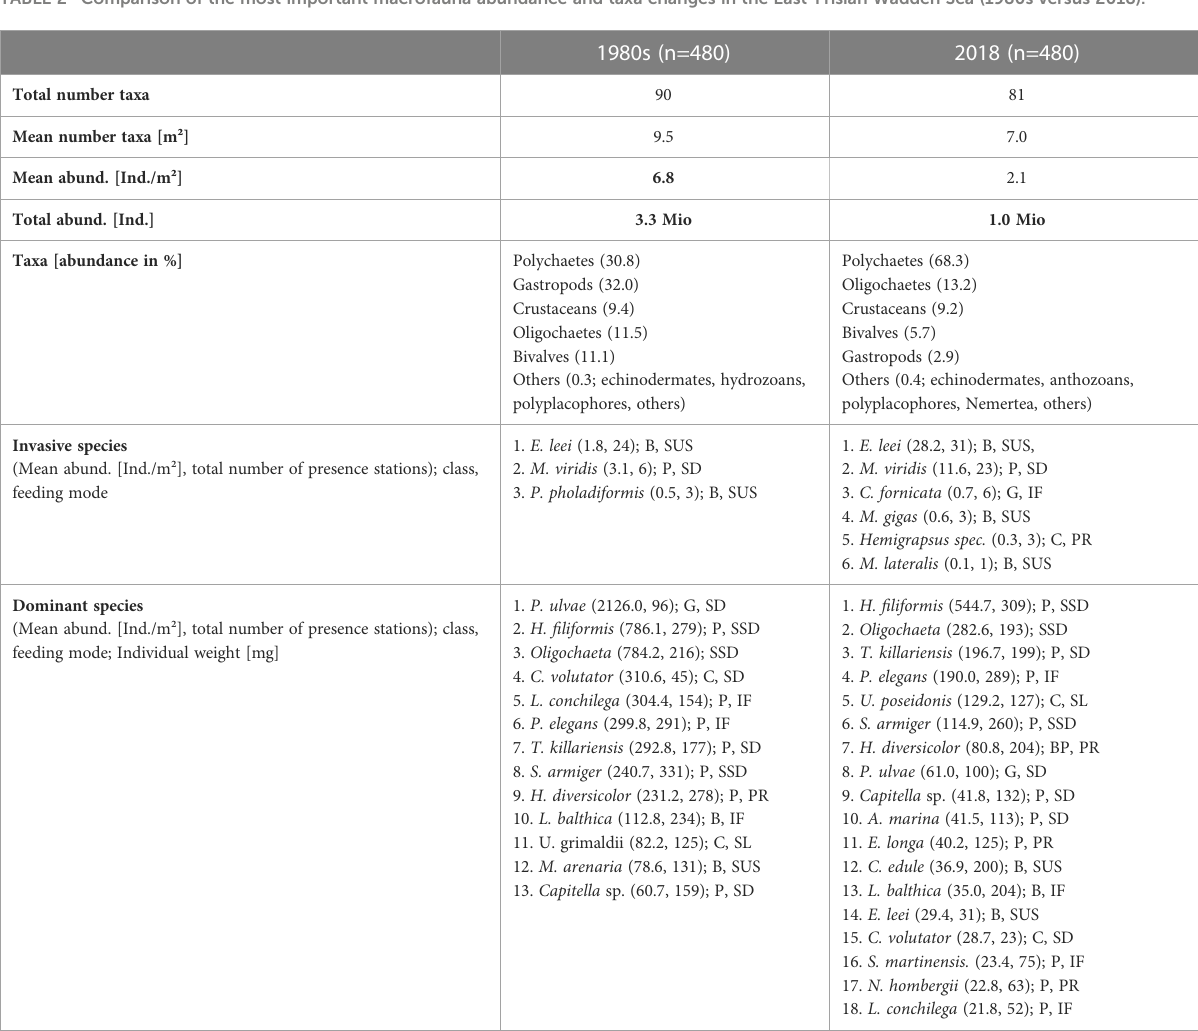
TABLE 2 Comparison of the most important macrofauna abundance and taxa changes in the East-Frisian Wadden Sea (1980s versus